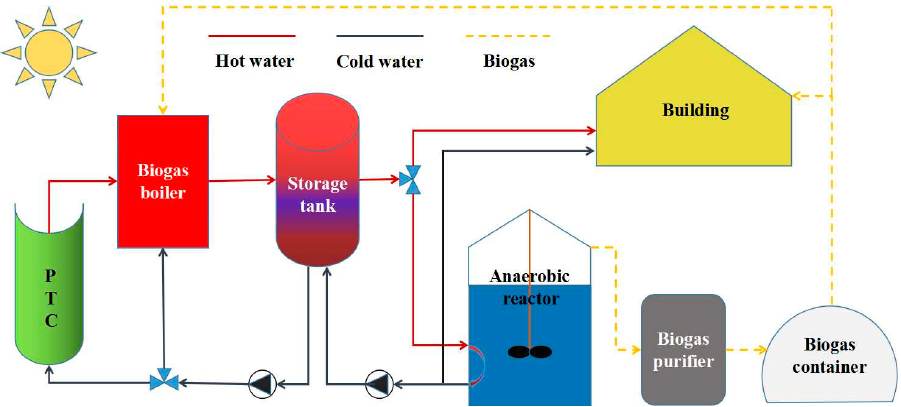
Figure 1. Schematic diagram of the hybrid solar-biomass district heating system.